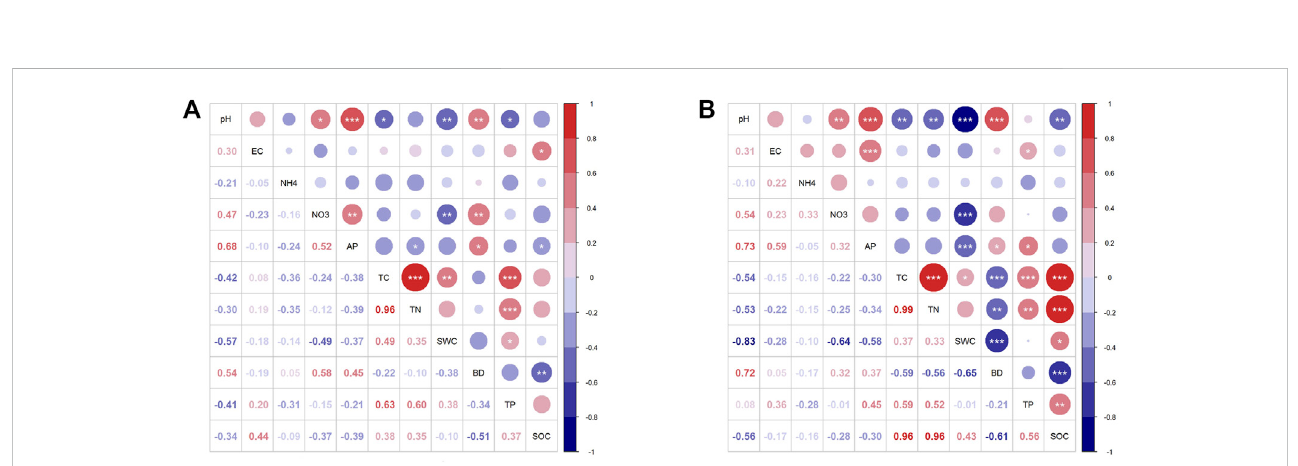
Spearman correlation analysis ofsoil physicochemicalproperties intheriparianzone: (A) river length direction; (B) river width direction. *: p < 0.1; **: p < 0.05;***: p < 0.01; fi gureswithout*indicate p > 0.1.pH:pHvalue;EC:Electricalconductivity;BD:Soilbulkdensity;SWC,soilwatercontent; TC,totalcarbon; TN, total nitrogen; TP, total phosphorus; AP, available phosphorus; SOC, soil organic carbon; NH 4 , ammonium nitrogen; NO 3 , nitrate nitrogen. The same is following Figures and